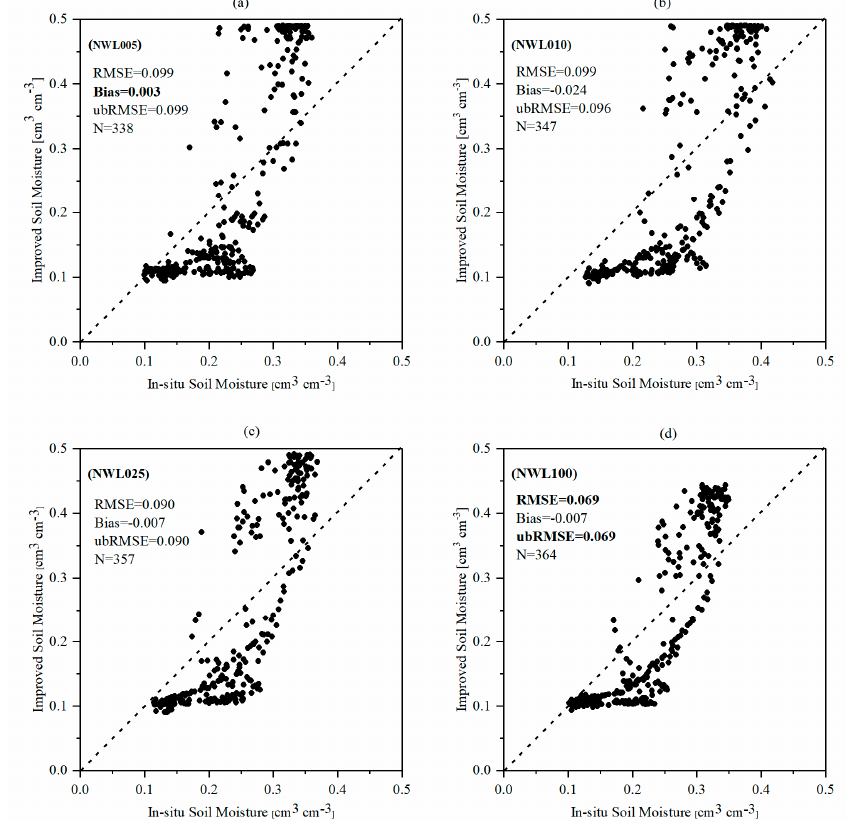
Figure 7. Scatter plots of FY_Imp SM against in situ SM measurements at four field SM networks. Error metrics are all in cm 3 cm − 3 and include: RMSE (root mean square error), Bias (mean bias) and ubRMSE (unbiased RMSE), N (the number of samples). The numbers in bold represent the best results for each error metric.